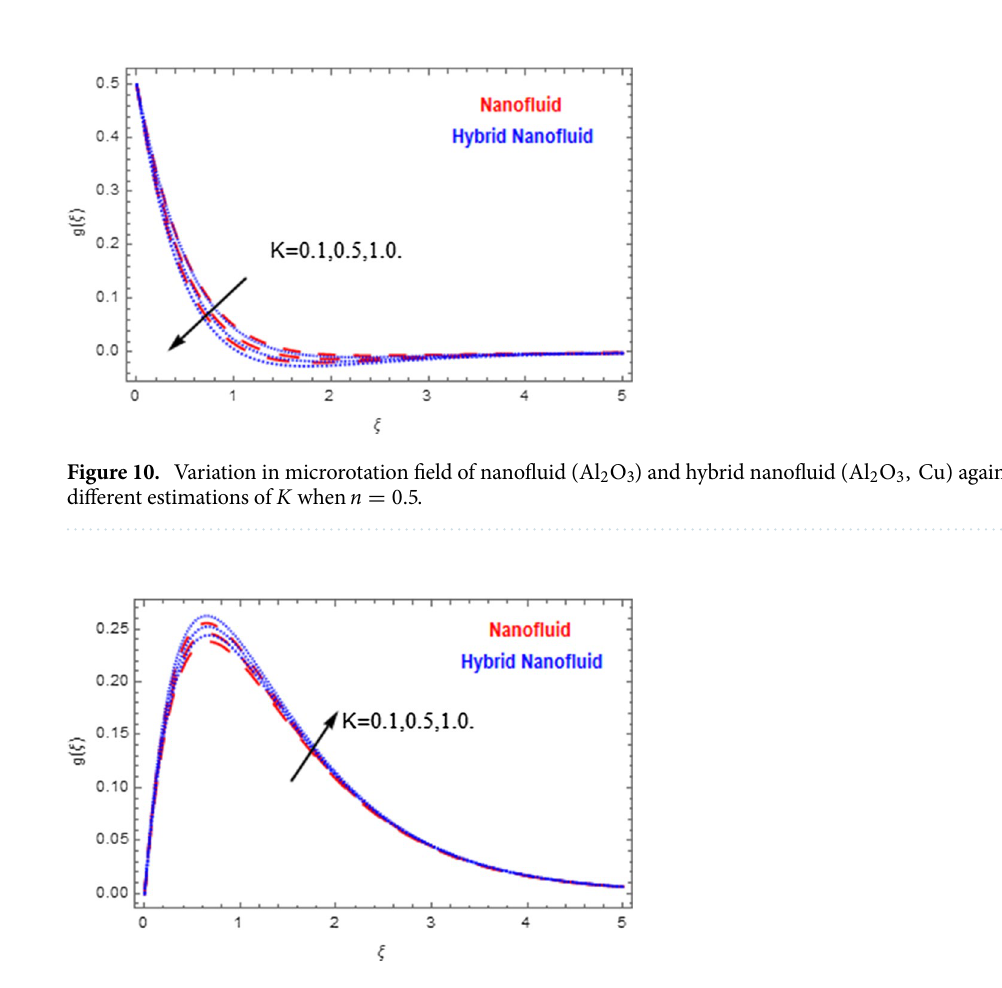
Figure 11. Variation in microrotation field of nanofluid ( Al 2 O 3 ) and hybrid nanofluid ( Al 2 O 3 , Cu ) against different estimations of K when n = 0